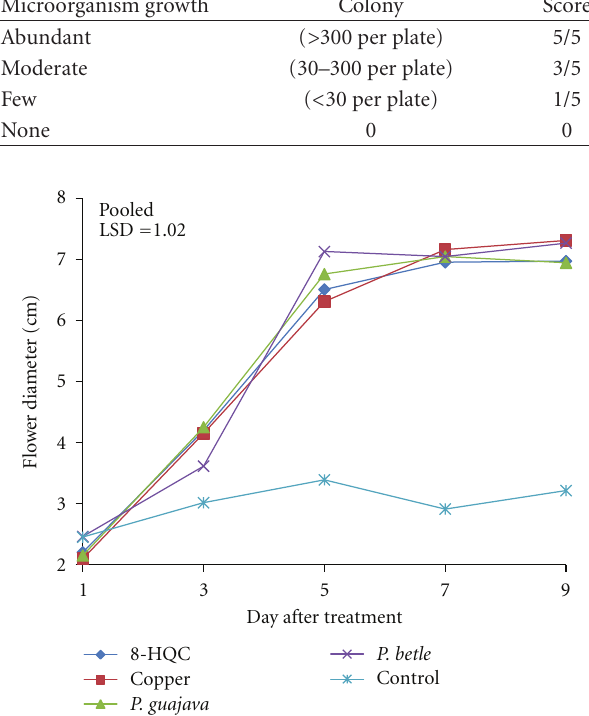
Figure 1: E ff ect of 8-HQC, copper coin, and leaf extracts of P. guajava and P. betle and control on flower diameter of “Carola” cut carnation flowers.